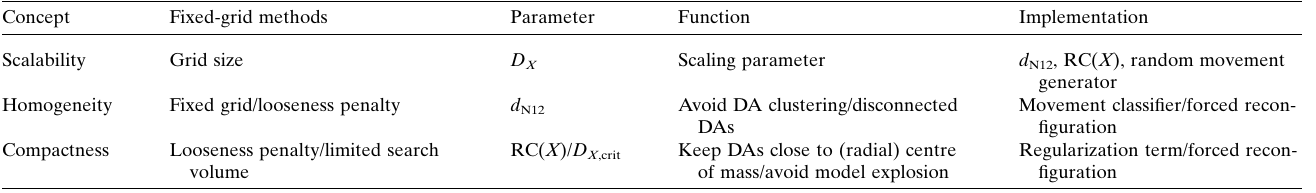
Table 1 Main concepts of the proposed grid-free fitting algorithm, the corresponding mathematical parameters, their function and their implementation compared with current solutions in fixed-grid DA modelling